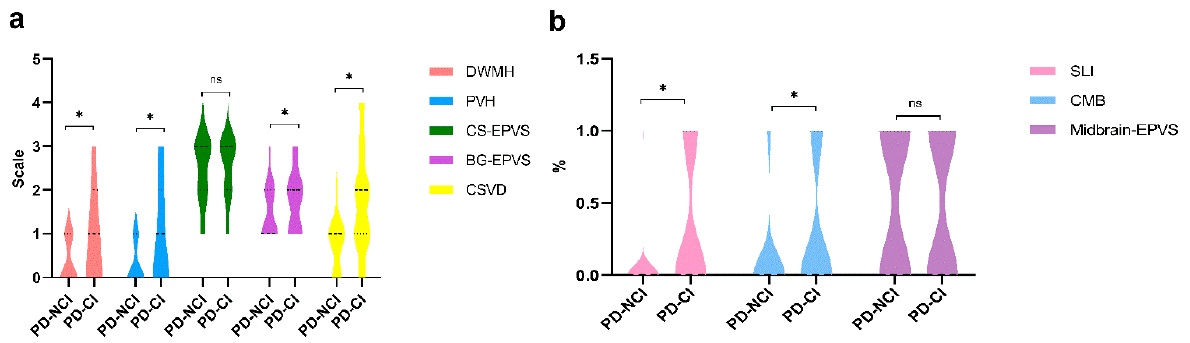
Figure 3. Violin plot of the comparison of the neuroimaging characteristics in two groups. ( a ) Comparison of the DWMH, PVH, CS-EPVS, BG-EPVS, CSVD in two groups; ( b ) Comparison of the SLI, CMB, Midbrain-EPVS in two groups. SLI, silent lacunar infarction; CMB, cerebral microb- leeds; DWMH, deep white matter hyperintensities; PVH, periventricular hyperintensities; BG-EPVS, enlarged perivascular spaces of basal ganglia; CS-EPVS, enlarged perivascular spaces of centrum semiovale; CSVD, cerebral small vessel disease. * p < 0. 05; ns represents no statistical